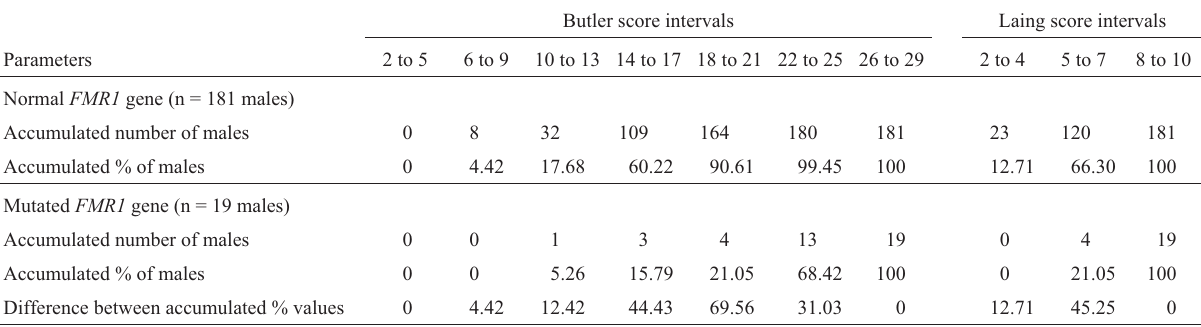
Table 1 - Accumulated score frequency distribution for mentally retarded males (n = 200) who showed a normal (181) or mutated (19) fragile X mental retardation gene ( FMR1 ) and had been scored for fragile X syndrome according to the checklists of Butler et al. (1991) and Laing et al. (1991). For each score interval the difference between accumulated percentage (Ac. %) values was calculated as the Ac. % for males with a normal FMR1 gene minus